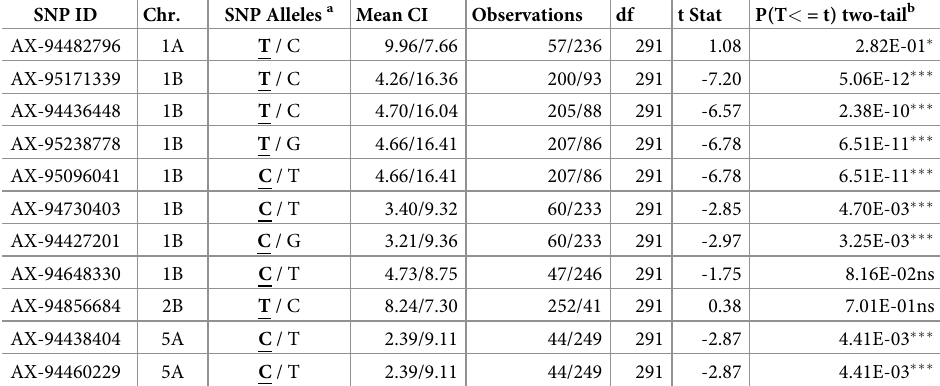
Table 7. Single locus-based variation of phenotypic values of resistant and susceptible alleles as resulted from two-sample T-test assuming equal variances. SNP ID Chr. SNP Alleles a Mean CI